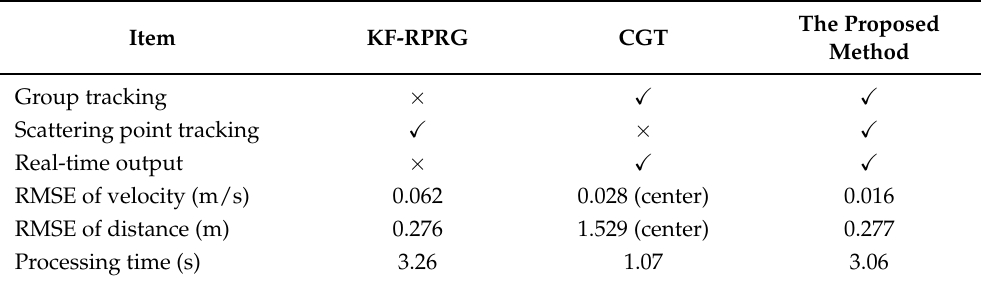
Table 3. The comparison between the KF-RPRG method, the CGT method, and the proposed MDCM- LT